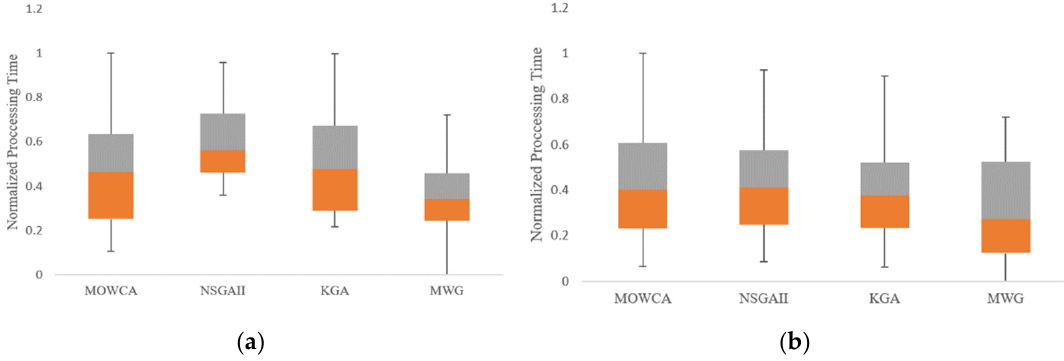
Figure 4. Comparison between algorithms due to the distribution of different solutions’ processing time in the resulted Pareto after 100 iterations for ( a ) 100 data items and ( b ) 400 data items.